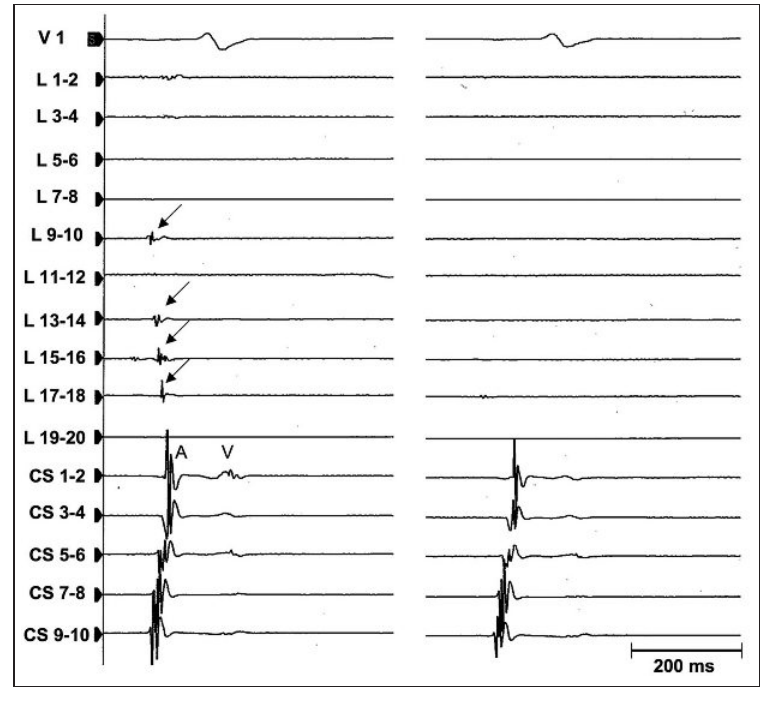
Left panel: Recording of PV potentials in sinus rhythm (arrows) on a circumferential mapping catheter (Lasso) before cryoballoon ablation. Shown are one surface lead (V1), and intracardiac electrograms recording the multipolar ring catheter (L 1-2 (distal) to L 19-20 (proximal) in the right superior PV, and the coronary sinus catheter (CS 1-2 (distal) to CS 9-10 (proximal).The patient was in sinus rhythm and there was conduction into the PV as evidenced by the recordings of PV potentials. A = atrial activation; V = ventricular activation. Right panel: Elimination of all PV potentials on the circumferential mapping catheter after two freezing cycles (2 × 300 seconds) with the cryoballoon catheter.